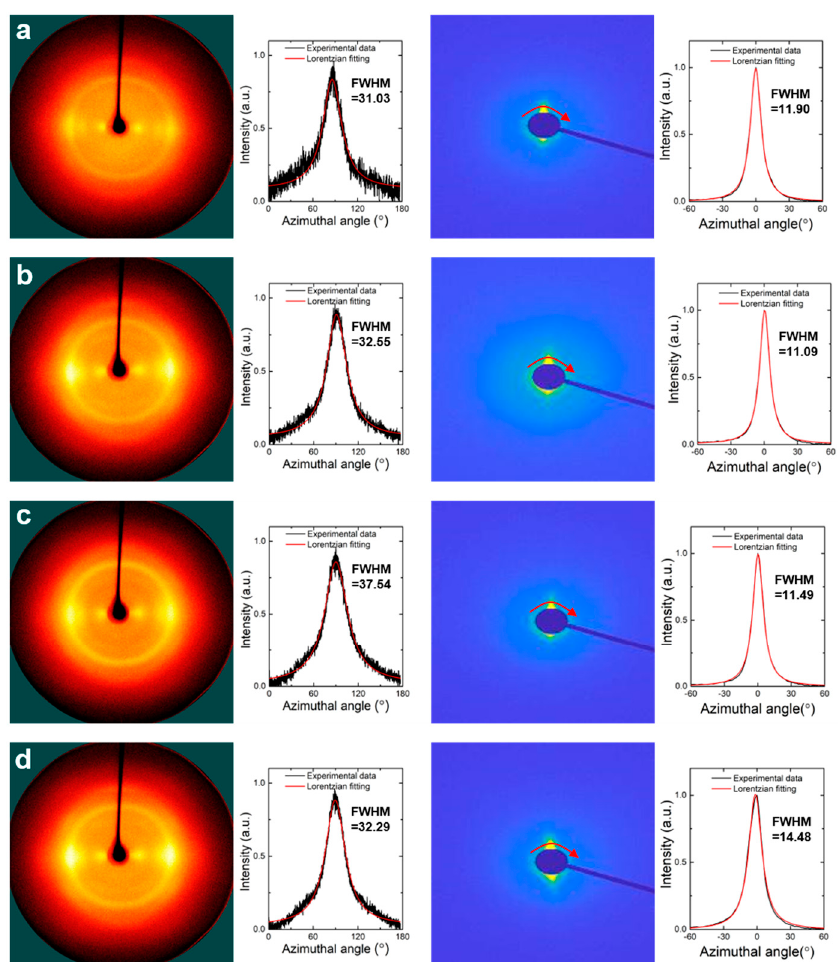
Figure 7. WAXS 2D pattern and angular scattered spectra (left) and SAXS 2D pattern and angular scattered spectra (right); ( a ) RSF for control, ( b ) RSF with vol 1% of LCNC, ( c ) RSF with vol 2% of LCNC, and ( d ) RSF with vol 5% of LCNC.